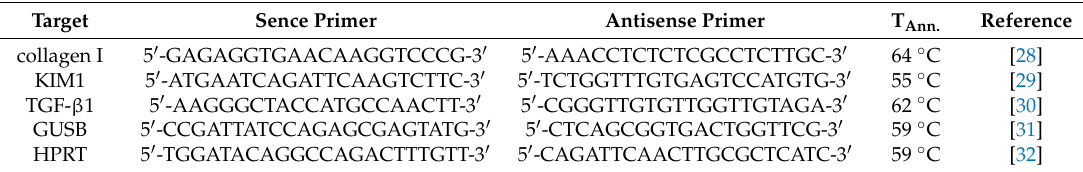
Table 1. Primer sequences and annealing temperature used for real-time